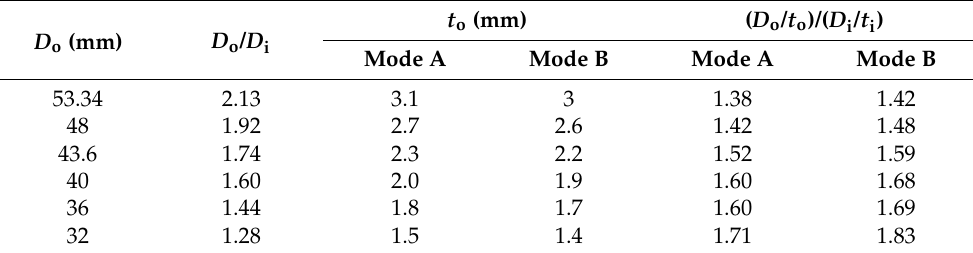
Table 10. The thickness of the outer pipe from both buckle propagation modes of cases with D o / D i less than 2.2 ( D i = 25 mm, t i = 2